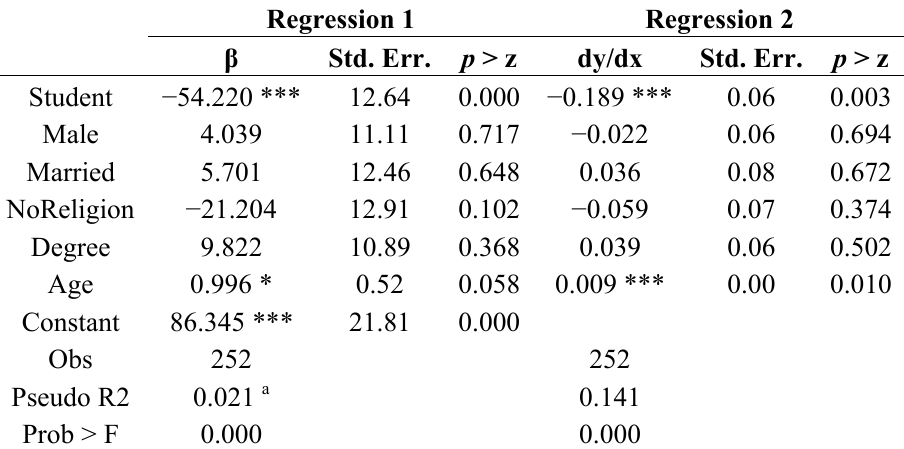
Table A7. Regression analysis (Dictator